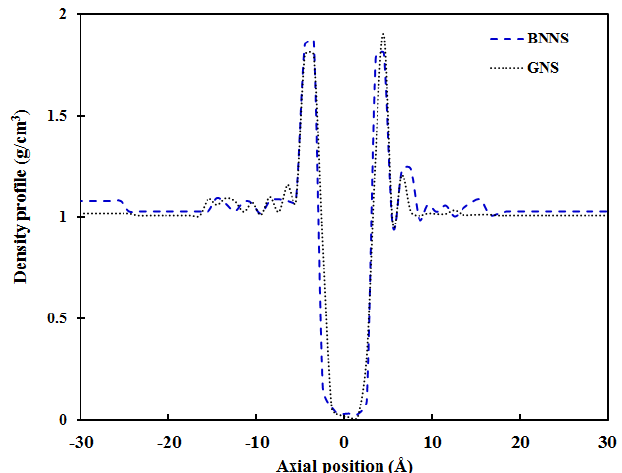
Fig. 7: Density profile of water molecules in the GNS and BNNS systems. Figure 7. Density profile of water molecules in the GNS and BNNS systems